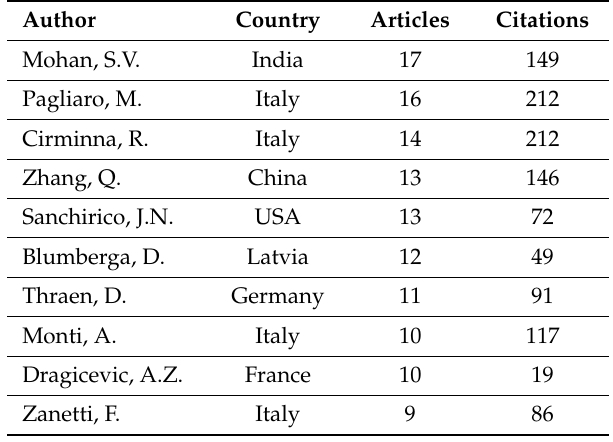
Table 5. The ten most prominent authors with number articles and citations ( n =